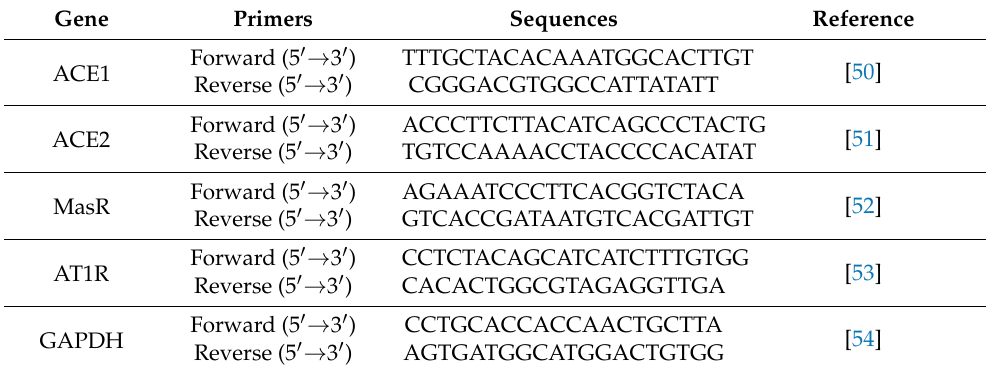
Table 2. List of the primer sequences used in a reverse transcription–quantitative polymerase chain reaction (qPCR) analysis of